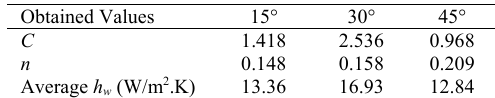
Table 1: Values of C, n, and hcw obtained for different inclinations of condensing cover Obtained Values